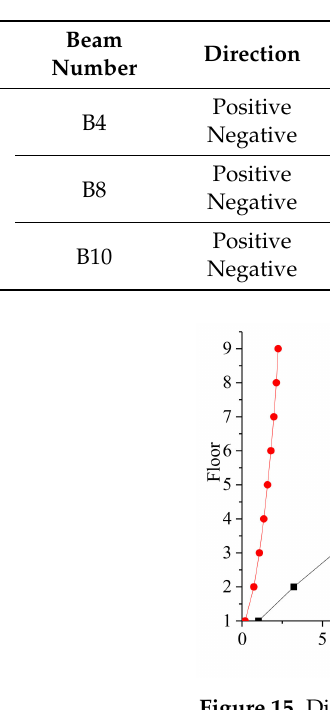
Table 9. Force condition of beams in case 1.